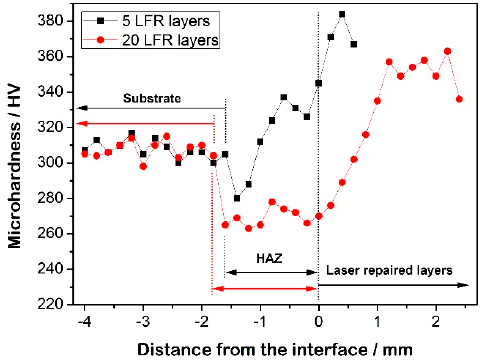
Figure 8. Microhardness distribution across the cross-section of the LFR samples.